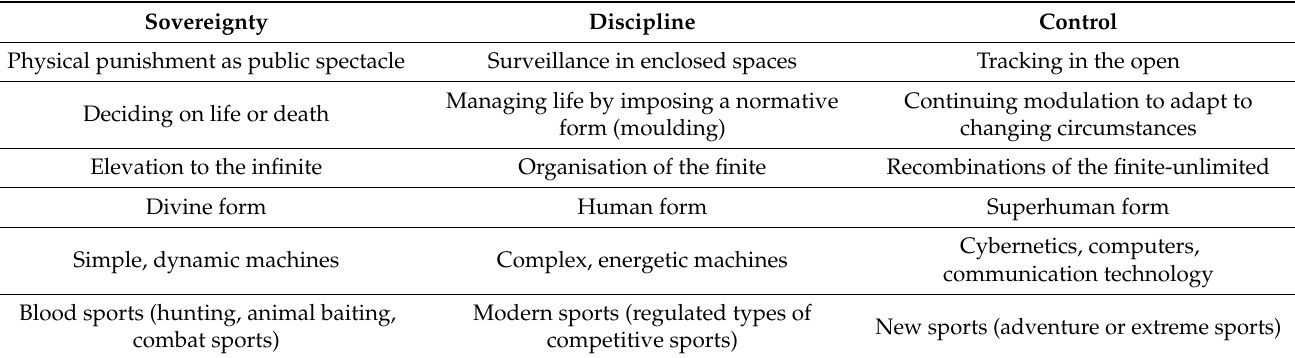
Table A1. The diachronicity of diagrams after Foucault and